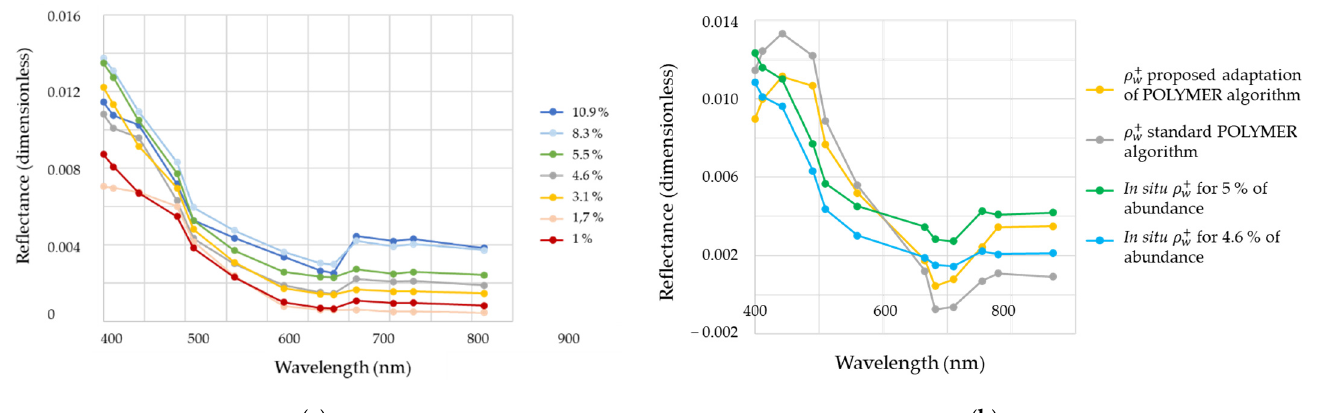
Figure 12. ( a ) Above water reflectance ( 𝜌 (cid:2933)(cid:2878) ) measured in situ in Sargassum -dominated areas in the Atlantic Ocean [20]. The different spectra correspond to different Sargassum abundances (%); ( b ) comparison of the spectrum water reflectance measured in situ when the abundance is 4.6, 4.8 and 5% with the reflectance derived from the standard and adapted atmospheric correction procedure.